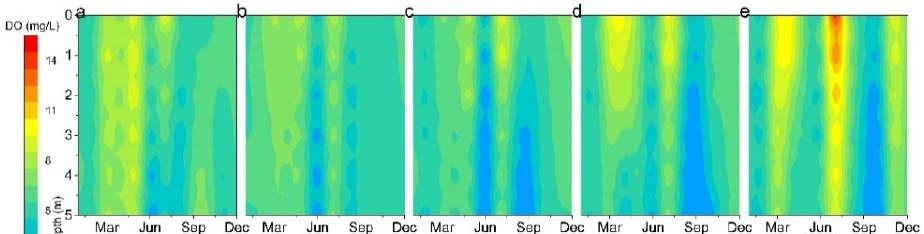
Figure 5. Spatiotemporal variation in DO in Lake Xingyun. measured during 2017. ( a ) XYH ‐ 1. ( b ) XYH ‐ 2. ( c ) XYH ‐ 3. ( d ) XYH ‐ 4. ( e ) XYH ‐ 5. ( b ) XYH-2. ( c ) XYH-3. ( d ) XYH-4. ( e )